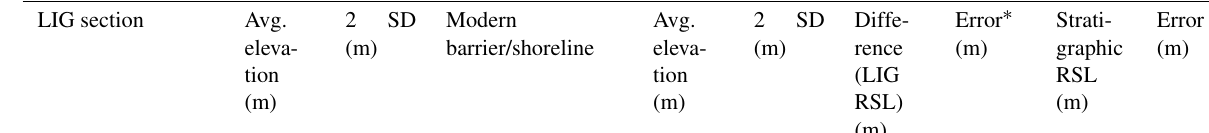
Table 1. Last interglacial Gulf of Mexico shoreline elevations and relative sea levels. Modern LIG section Avg. barrier/shoreline eleva-